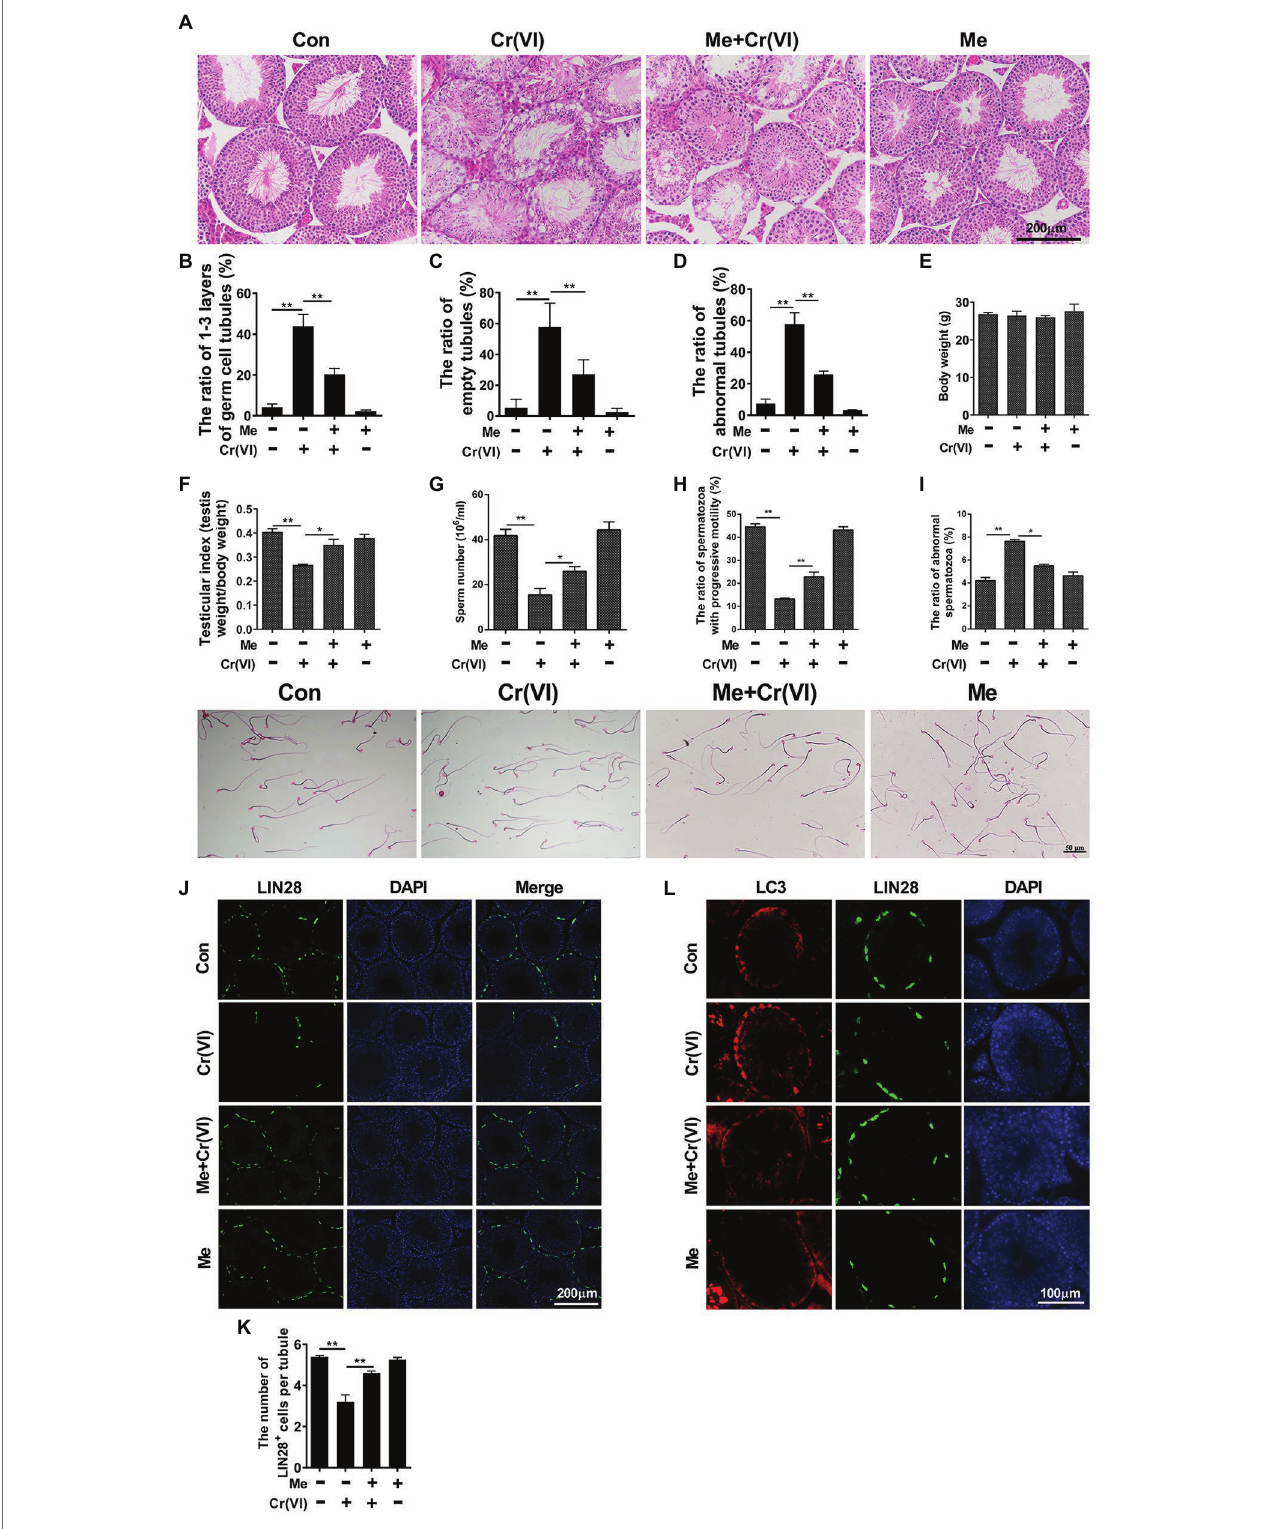
FIGURE 5 | Melatonin alleviated Cr (VI)-induced damage to male reproductive system and autophagy in mouse testes. (A) H&E staining of testis sections from the control, Cr (VI), melatonin + Cr (VI), and melatonin-treated mice. Bar = 200 μ m. (B–D) The ratios of only 1–3 layers of germ cell (B) , empty (C) , and